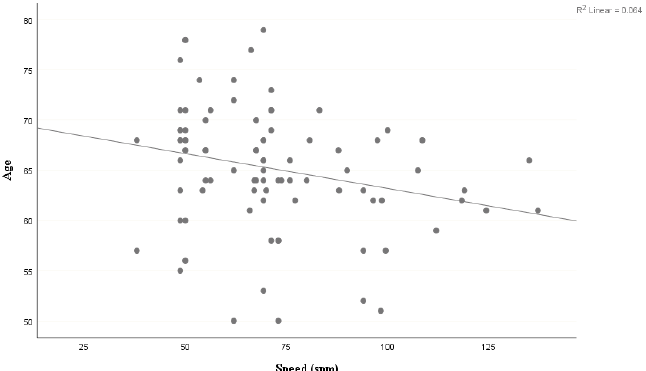
Figure 3. Correlation between speed (spm) and MoCA score in older adults.